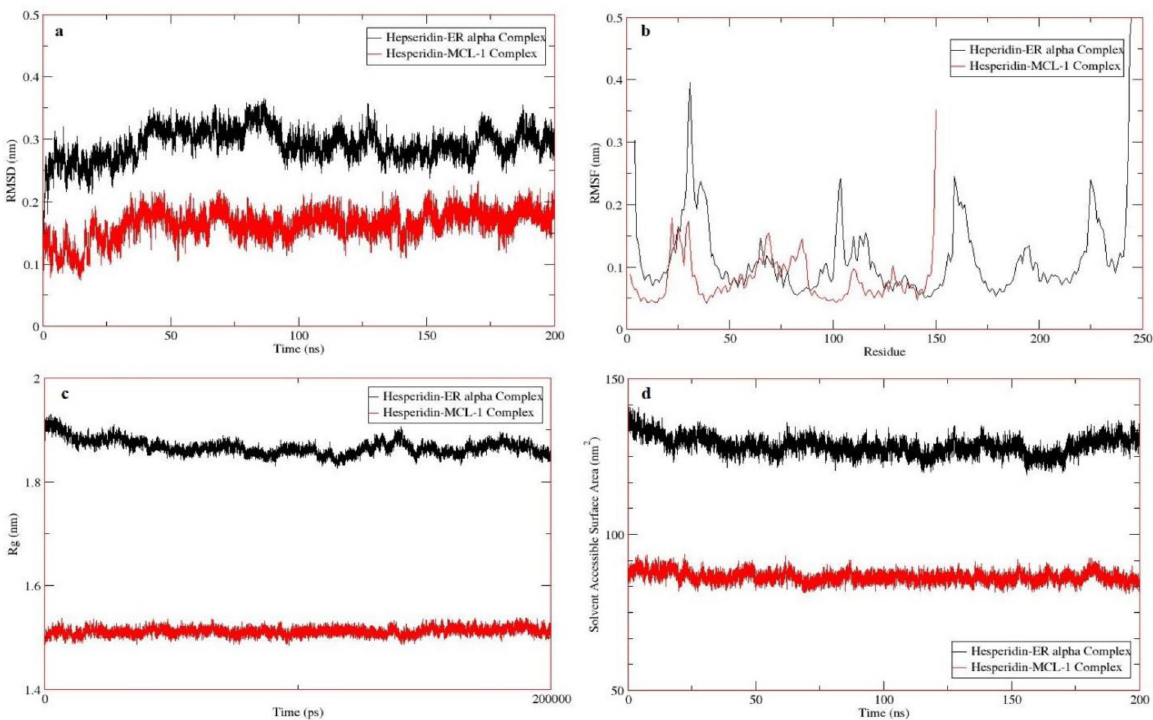
Fig 2. Molecular dynamics simulation of the hesperidin-MCL-1 and hesperidin-ER α complexes at 310.15 K for 200 ns. a) RMSD plot, b) RMSF plot, c) Rg plot, and d) SASA plot.